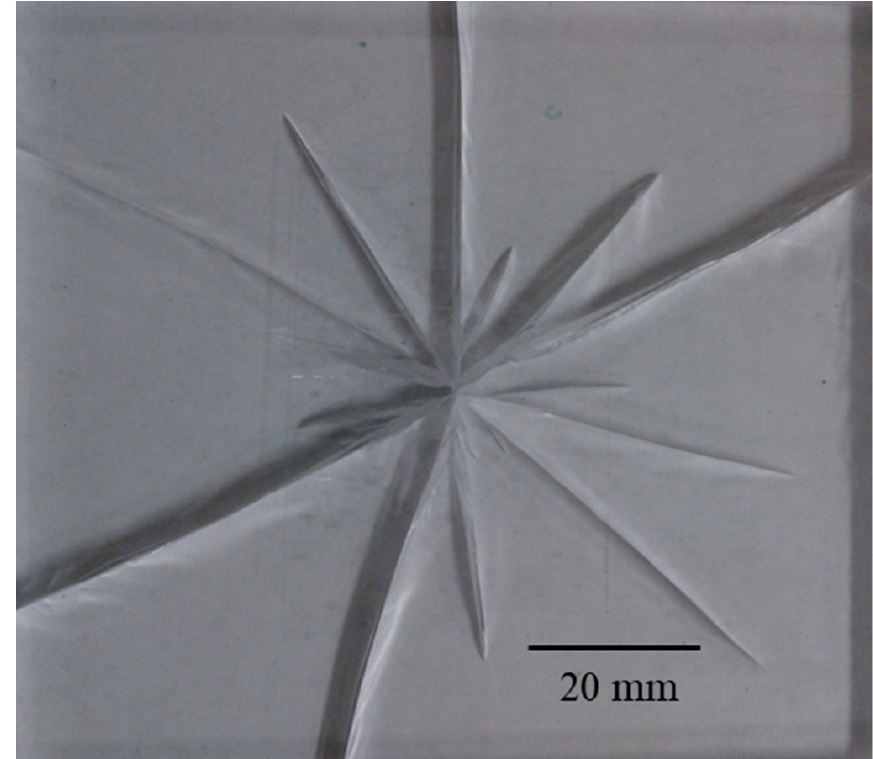
Figure 7. Top view of a damaged baseline specimen at 12 J energy.